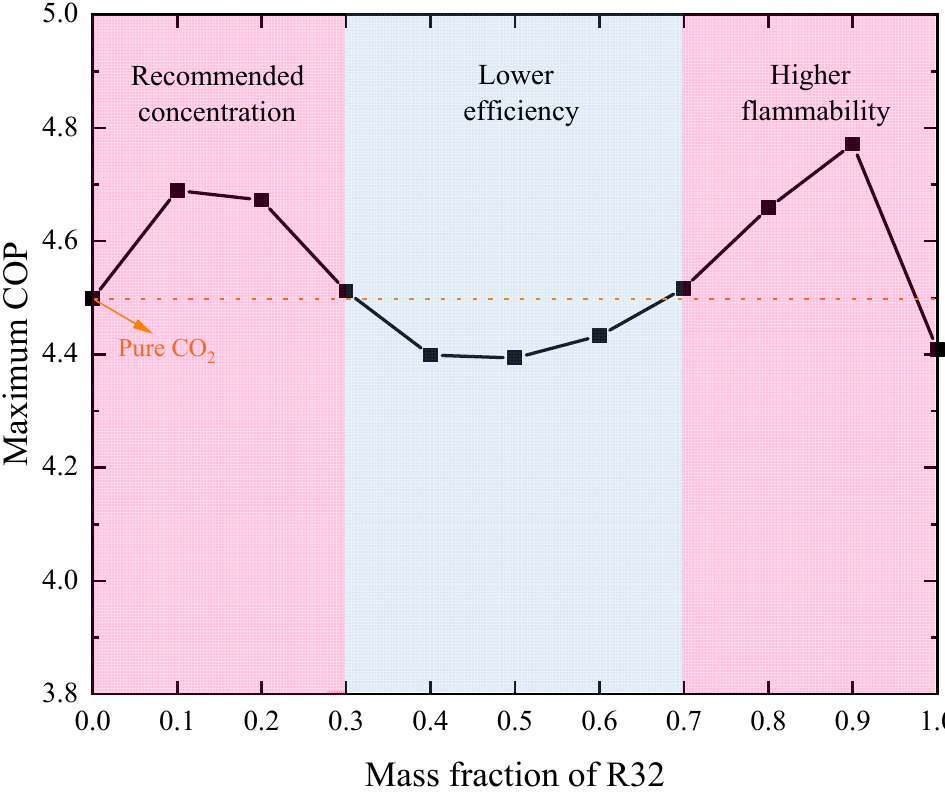
Figure 4. The maximum COP across the R32 mass fraction range.